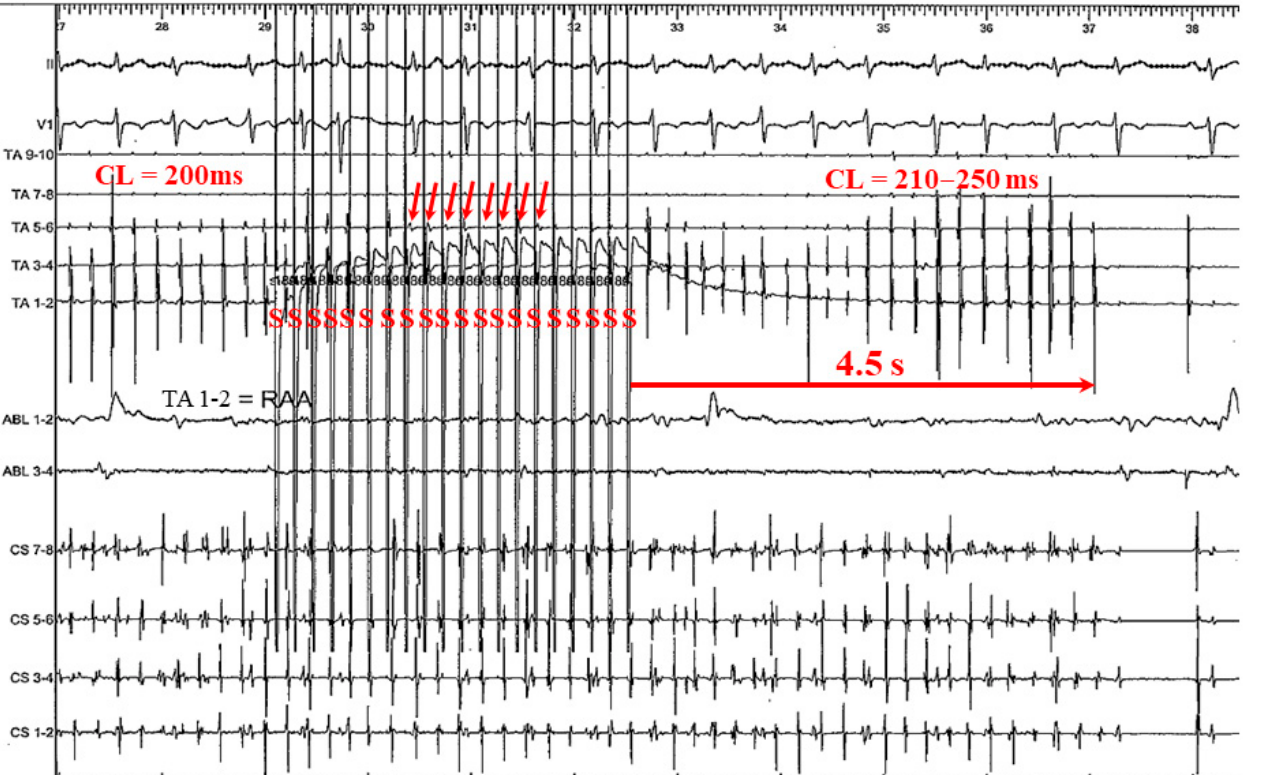
Figure 2. Case 1. Burst pacing was attempted from the right atrial appendage, and AF was terminated after 4.5 s. In this case, 8/20 pacing impulses captured the RA (arrows), resulting in slowing of AF CL prior to AF termination. AF = atrial fibrillation; CL = cycle length; CS = coronary sinus; RAA = right atrial appendage; PAF = paroxysmal AF; S = stimulation: TA = tricuspid annulus.